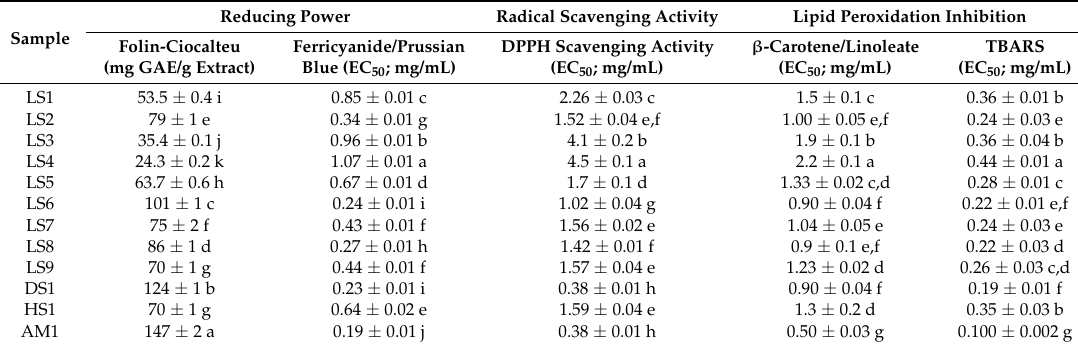
Table 5. Antioxidant activity of the studied edible